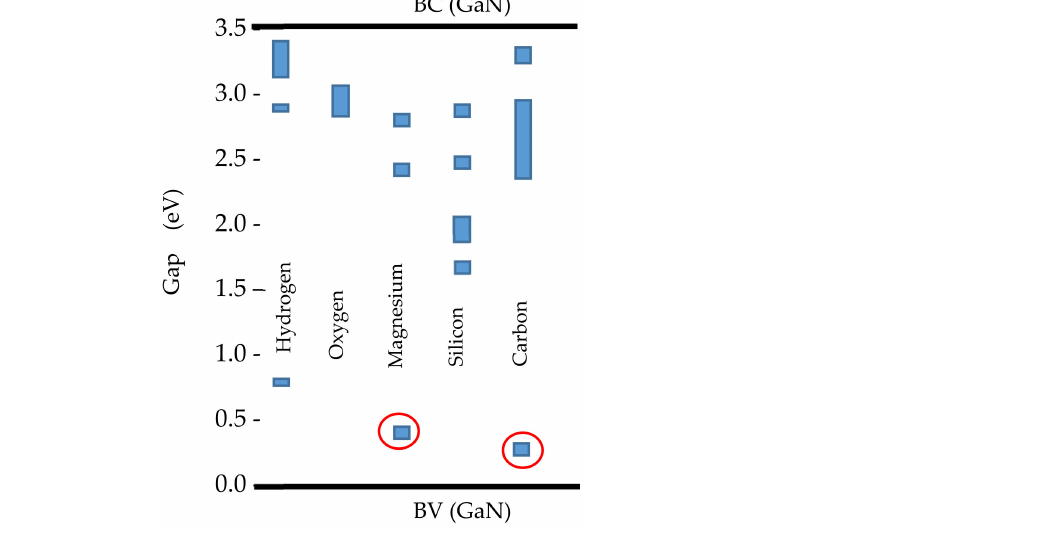
Figure 11. Traps levels due to impurities in GaN material: Allowed energy levels inside the forbidden GaN gap caused by impurities. Zero energy correspond to the upper border of the valence band (own elaboration based on